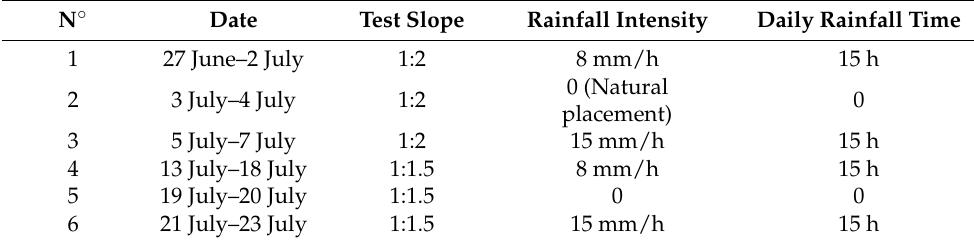
Table 3. Experimental history.